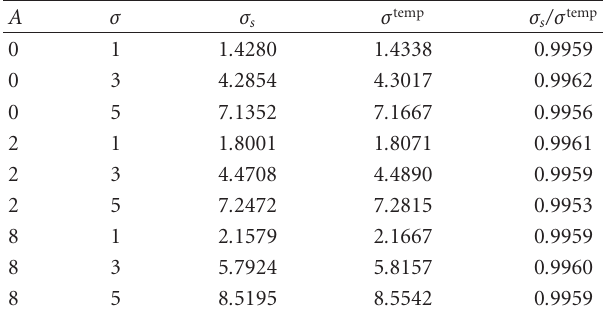
Table 3: Measured temporal standard deviation σ temp , the mean standard deviation σ s in the di ff erence images, and the ratio /σ temp . σ s